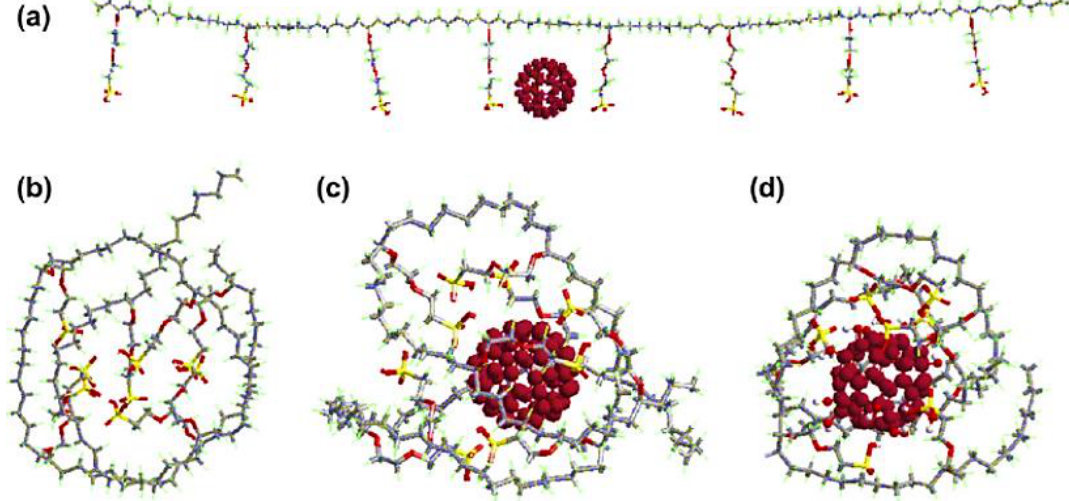
Figure 6. ( a ) Initial structure of C 60 and Nafion oligomers; ( b ) snapshots of Nafion oligomers; ( c ) C 60 and Nafion oligomers; and ( d ) polyhydroxy and Nafion oligomers (taken after 1 ns molecular dynamic simulations) [176]. Reproduced with permission from Elsevier.